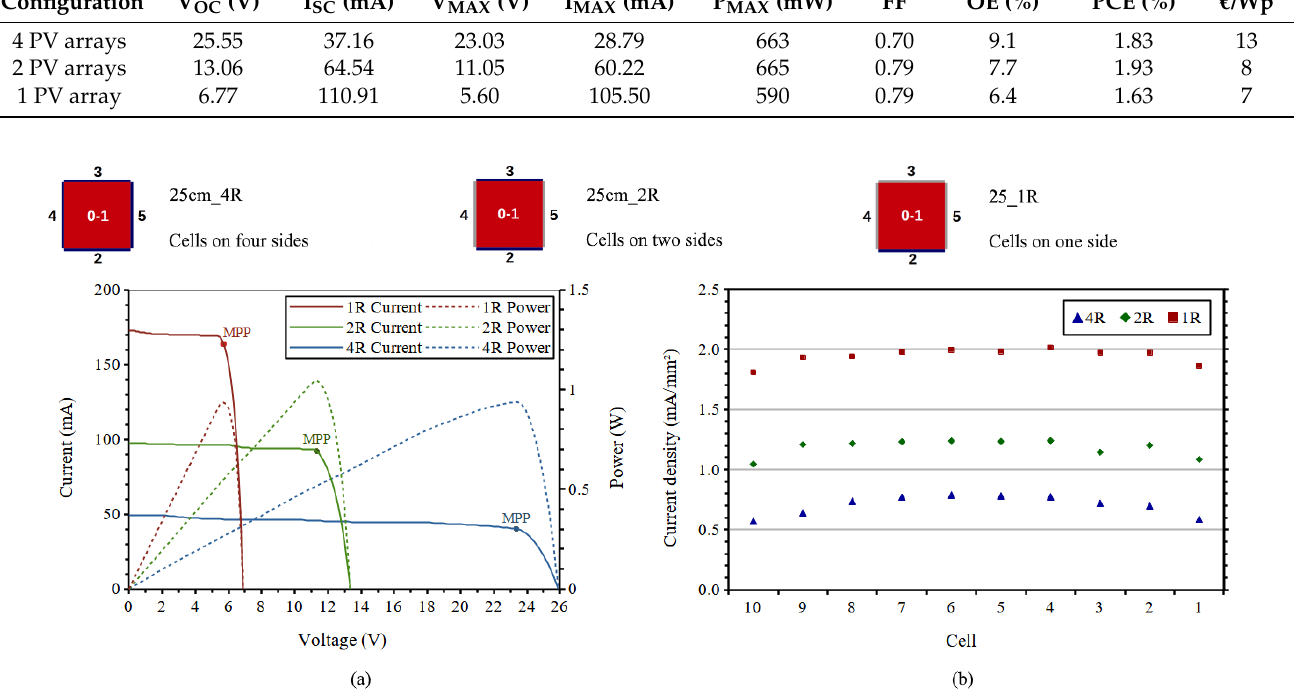
Figure 20. Characteristic curves (I-V and P-V) of the unshaded LSC panel with one 10-cells PV array and functionalized with 300 ppm of Lumogen ® F Red 305.